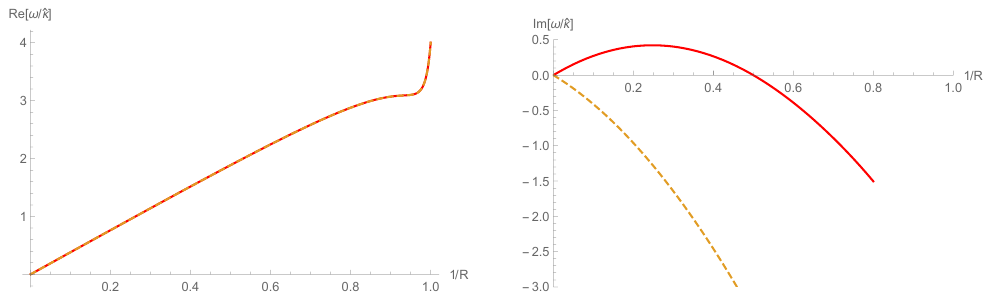
Figure 4 . The frequencies ! ( ‘ =0) (solid line) and ! ( ‘ =0) (dashed line) of the scalar-type quasinormal + (cid:0) modes of the EGB black ring with ‘ = 0, m = 2 and ~ (cid:11) = 2. The real part and the imaginary part are depicted in the left and right panel respectively, both of which are in unit of the reduced surface gravity ^ (cid:20) . Im[ ! ( ‘ =0) ] is positive for R > 2 which signals the GL-like +